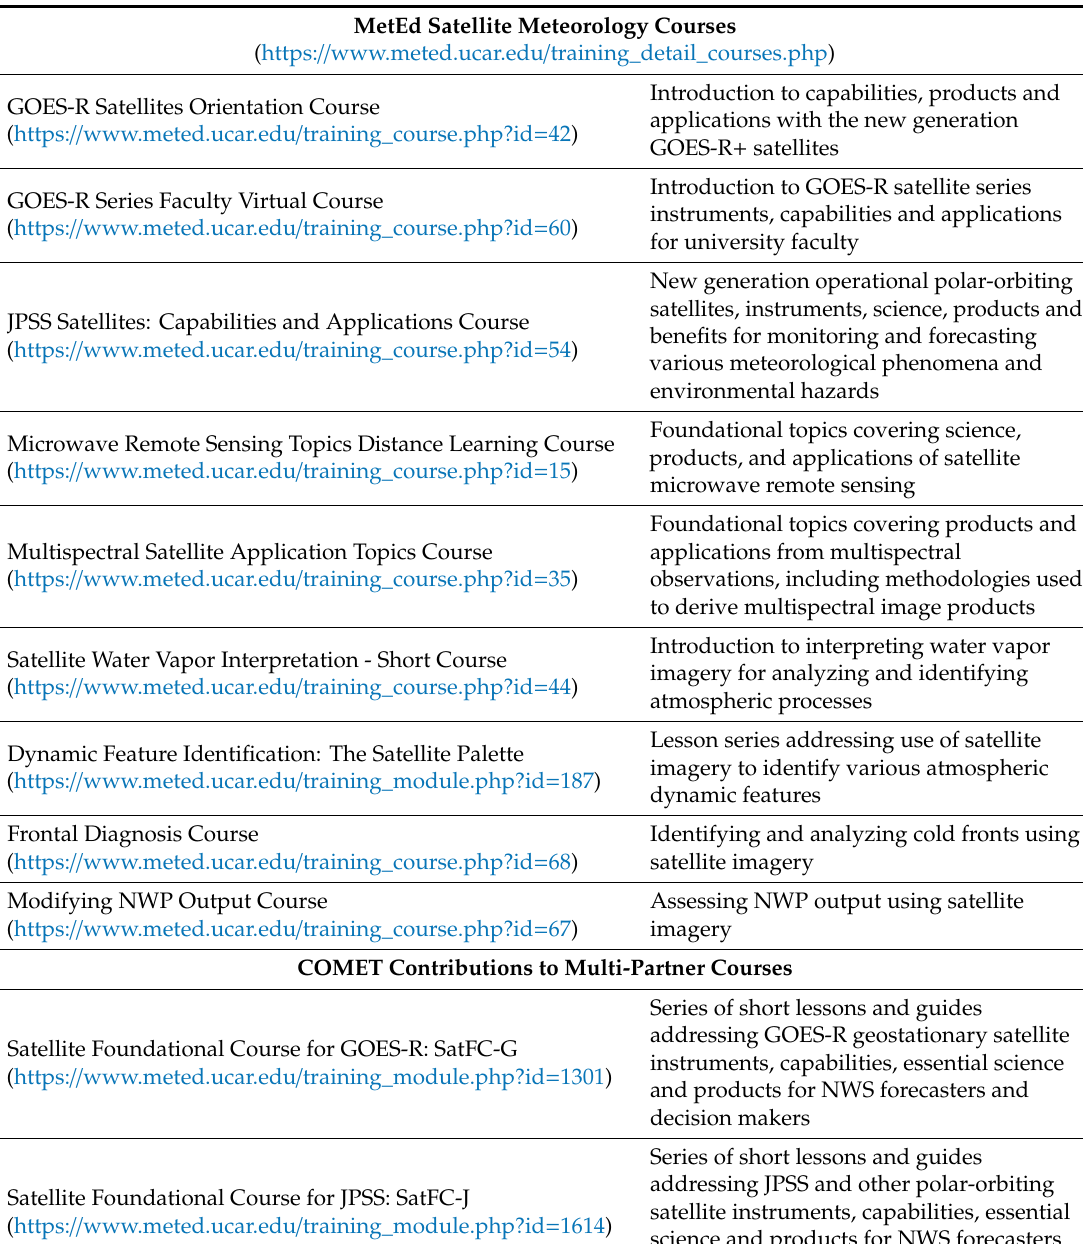
Table 2. MetEd courses and course